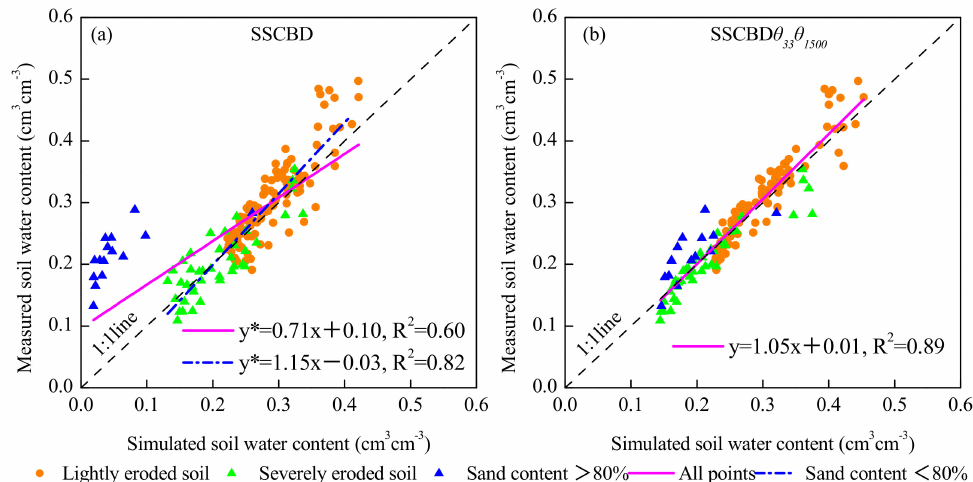
Figure 7. Comparison of the measured and simulated soil water contents using the input of SSCBD ( a ) and SSCBD θ 33 θ 1500 ( b ), respectively. * means there were significant di ff erences at p = 0.05 between the 1:1 line and the fitting line with the t